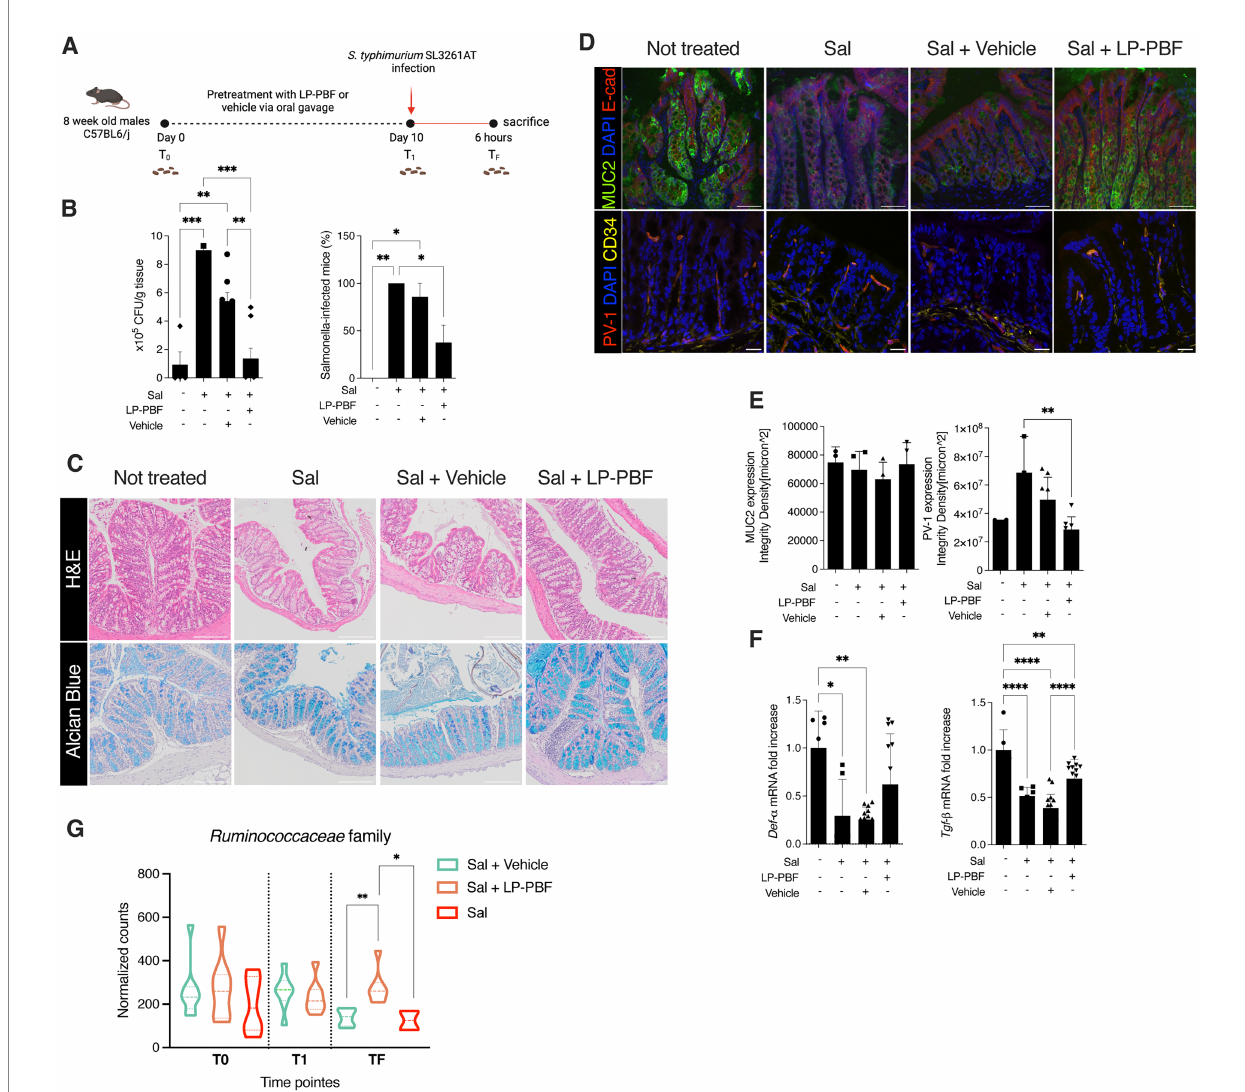
FIGURE 2 Lactobacillus paracasei CNCM I-5220-derived postbiotic prevents the disruption of IEB upon S. typhimurium infection. (A) Schematic representation of experimental design (created with Biorender). 8-week-old C57BL6/J male mice were treated for 10 consecutive days with 135 mg/kg/day of LP-PBF or vehicle via oral gavage. After the pretreatment, mice were infected with 10 9 CFU of S. typhimurium SL3261AT and upon 6 h were sacrificed. (B) S. typhimurium SL3261AT dissemination in colon (left) and liver (right) after 6 h of infection. * Statistical analysis was evaluated using One-way ANOVA, Tukey’s multiple comparisons test. (C) Panel represent histology analysis performed on FFPE sections: H&E staining (upper panel) and Alcian Blue (bottom panel). Scale bar – 20 μm. (D) Representative immunofluorescence analysis performed on colon OCT sections, in following order: MUC2 (upper) and PV-1 (bottom). Scale bar—20 μm. (E) Fluorescent intensity quantification of MUC2 (left) and PV-1 (right). * Statistical analysis was evaluated using One-way ANOVA, Tukey’s multiple comparisons test. (F) Graph represent fold change of mRNA expression of α -Defensin and Tgf- β in colon of different groups analyzed. * Statistical analysis was evaluated using One-way ANOVA, Tukey’s multiple comparisons test. (G) Graph represent the normalized counts of Ruminococcaceae family in different experimental groups and different time points. * Statistical analysis was evaluated